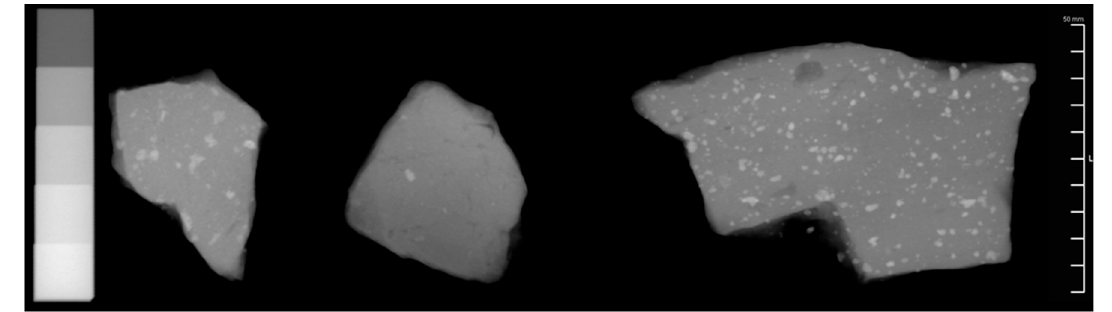
Figure 9. Aluminum standard and ceramic fragments radiography from the SP, RP, and SB, respec- tively. The whiter regions of the samples represent the denser parts of the material.